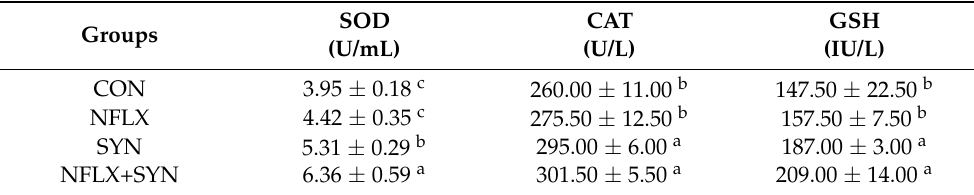
Table 5. Changes in serum sodium dismutase (SOD), catalase (CAT), and reduced glutathione (GSH) in O. niloticus fed diets supplemented with antibiotic (Norfloxacin NFLX) and synbiotic (SYN).